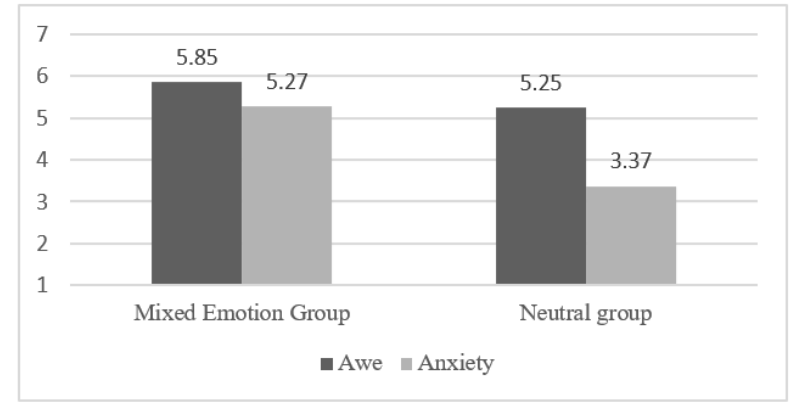
Figure 2. Graph of mean values of awe and anxiety for both groups.